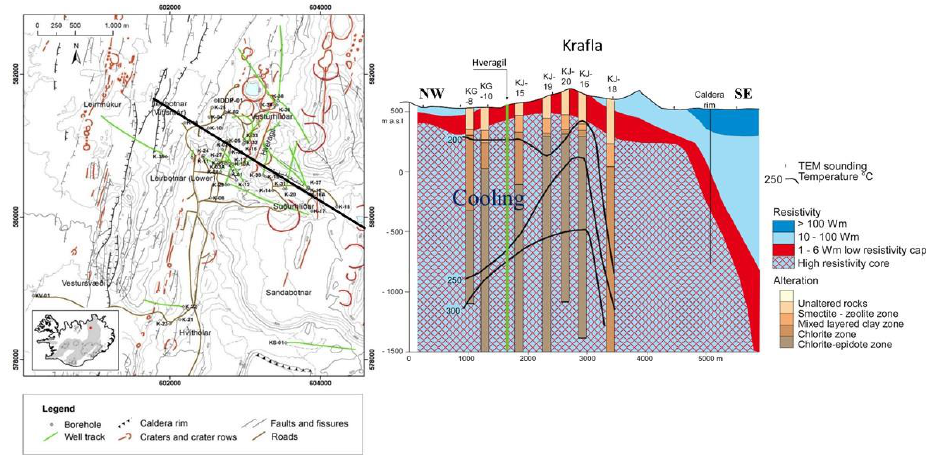
Figure 14. Left; The locations and tracks of wells in Krafla (green lines) and the location of the cross-section to the right (black line). Right; A resistivity cross-section with alteration mineralogy and formation temperature in wells.